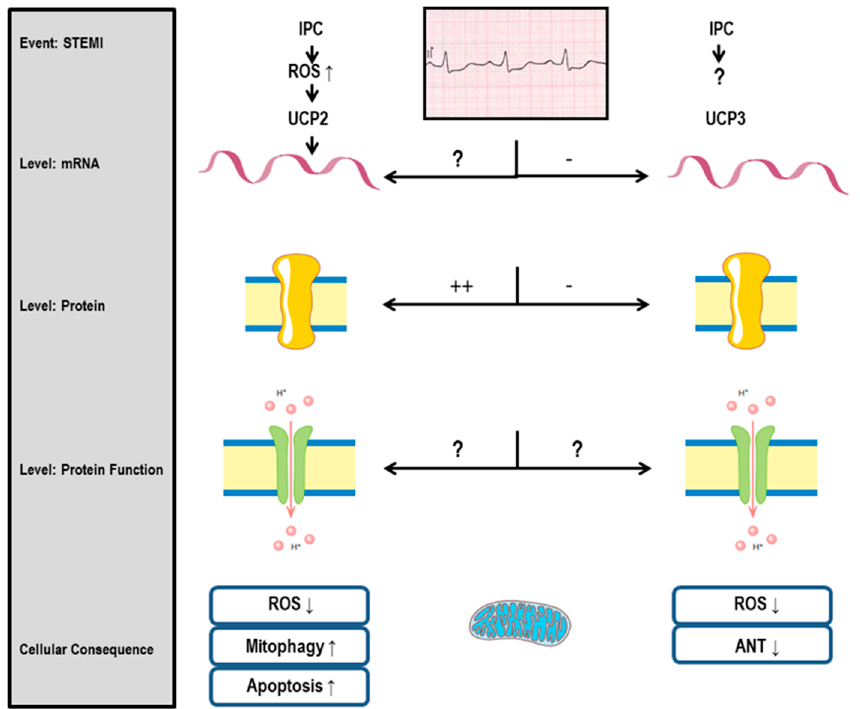
Figure 1. Myocardial Infarction (STEMI) strongly induces uncoupling protein (UCP) 2 expression (level protein). Short periods of ischemia, as performed by ischemic preconditioning (IPC), can also induce UCP2 mRNA expression (level mRNA). Whether this increases the protonophoric function of UCP2 has not been analyzed (levels protein function). The cellular consequences are linked to altered mitochondrial function and include reduced reactive oxygen species (ROS) production and increased mitophagy, but also increased apoptosis. In contrast, STEMI seems to reduce the mRNA and protein expression of UCP3. Decreased expression of UCP3 lowers protection via ROS reduction and adenine nucleotide transporter (ANT) inhibition, which was linked to UCP3 but not UCP2 (see details in text).